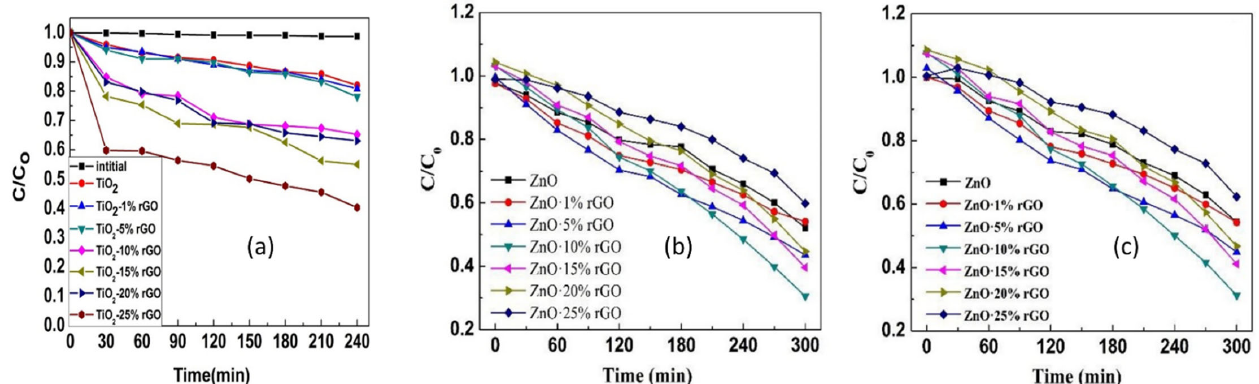
Figure 5. ( a ) The absorption peaks at 255 nm and 349 nm are due to the absorption by the Cr 6+ ions in the presence of x% rGO nanocomposites NCs. Photocatalytic reduction of Cr 6+ by ZnO · x% rGO NCs deduced at the wave length of ( b ) 273 and ( c ) 373 nm from absorbance of the light. The figure is reproduced with the permission from [125,126] .